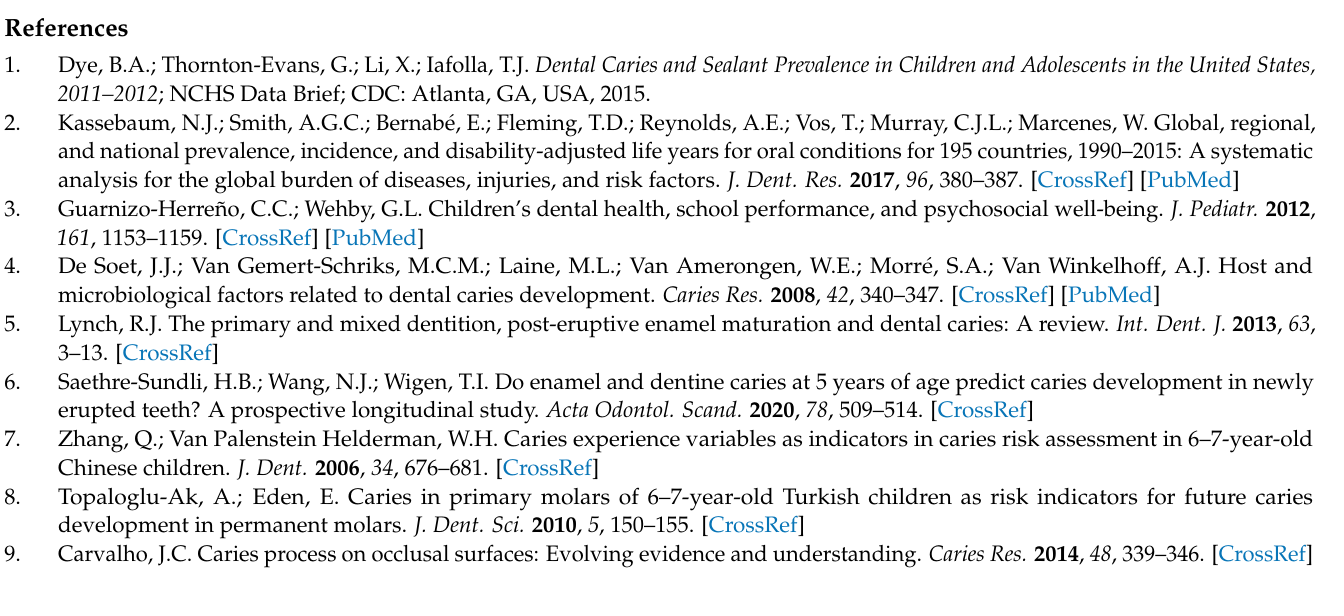
Code—tooth nomenclature using Palmer notion; dmft/DMFT—decay missing filled tooth index, per individual tooth type. For the sequencing experiments, we selected (highlighted in grey): primary first molars from